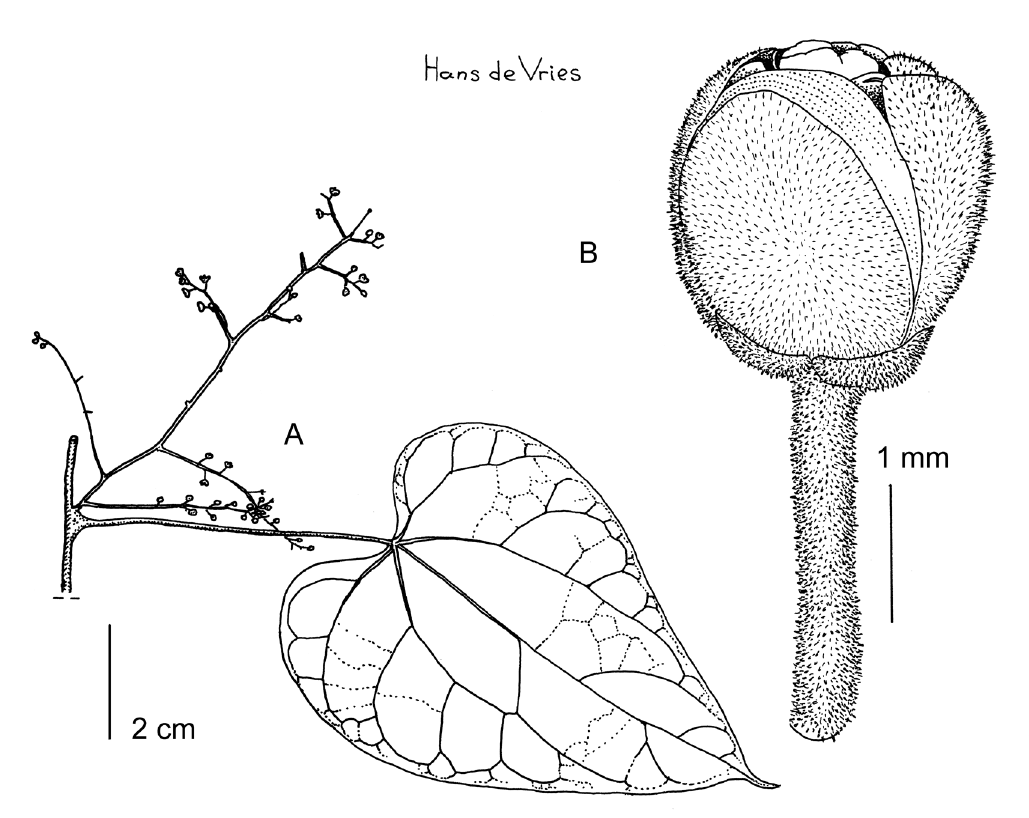
Figure 11 – Rhigiocarya nervosa . A . Part of flowering branchlet. B . Flower bud showing minute indumentum. A–B from Bos 2093 (WAG). Drawn by Hans de